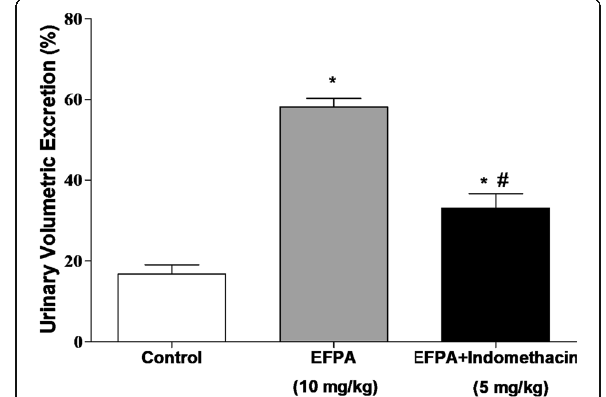
The urine volumes expressed as mL/100 g were calculated based on body weight of rats and urinary volumetric excretion values are expressed as a percentage of the initial hydric overload (50 mL/kg). Data are given as means ± SEM of 6 different experiments. Statistical analyses were assessed using two-way analysis of vari- ance (ANOVA) followed by Bonferroni ’ s post- test. * p ˂ 0.001 versus control (119.3 ± 4.4 mEq/L; Table 3; Additional file 3: Figure S3). The plasma chlorine level observed in rats following the EFPA treatment was 102.0 ± 4.3 mEq/L, similar to that ob- served in the control group (104.3 ± 3.9 mEq/L), and not af- fected by indomethacin (103.3 ± 3.4 mEq/L; Table 3; Additional file 3: Figure S3). The potassium level was sig- nificantly reduced after EFPA treatment (70.5 ± 2.9 versus 54.7 ± 2.8 mEq/L; respectively in the control and EFPA group), this effect was not affected by indomethacin (Table 3; Additional file 3: Figure S3). The plasma calcium level following EFPA treatment was similar to that of the control group (5.2 ± 2.6 mEq/L and 5.4 ± 2.5 mEq/L, re- spectively) and this response was not affected by indometh- acin (5.1 ± 2.5 mEq/L; Table 3; Additional file 3: Figure S3). Effect of EFPA on renal function After 24 h, the EFPA treatment (10 mg/kg for 24 h) affected slightly but not significantly the plasma concen- tration of urea and creatinine in rats, both responses